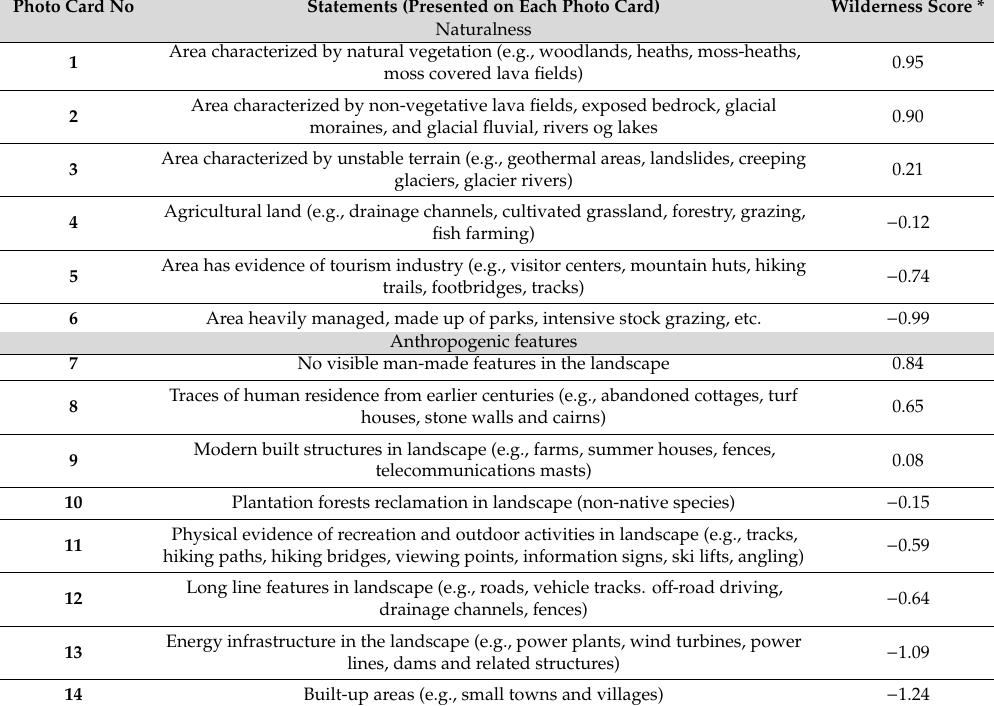
Figure 11. The most important attributes stimulating Icelanders’ perception of wilderness calculated as range of wilderness-scores for each attribute scenario.